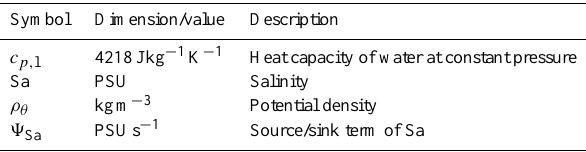
Table 3. List of ocean model